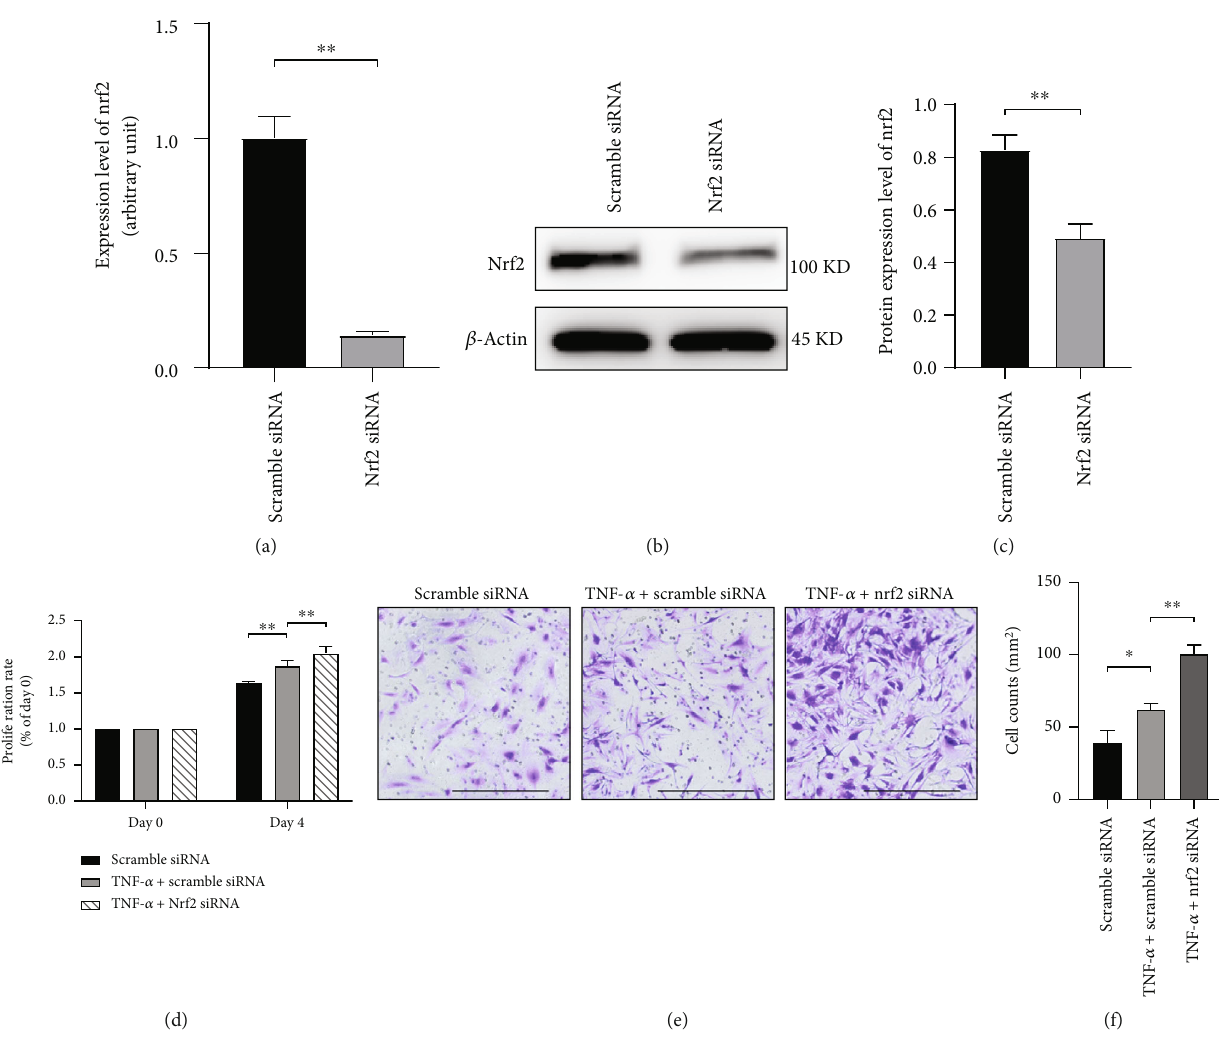
Figure 3: Knockdown of nrf2 promoted TNF- α -induced proliferation and invasion of RA-FLS. (a) Nrf2 mRNA expression was reduced by nrf2 siRNA transfection for 48 h, as revealed by real-time PCR. (b, c) The protein expression level of nrf2 was examined after nrf2 siRNA transfection for 72h by Western blotting. β -Actin was used as the housekeeping gene. (d) The proliferation rate of RA-FLS was analyzed by CCK-8 assay after transfection with scramble siRNA or nrf2 siRNA for 72h. Cells were examined before and after 4 days of culture in the presence or absence of TNF- α (25 ng/mL). The proliferation rate was expressed as the relative optical density (OD) value at 450nm between day 4 and day 0. (e, f) Invasion of RA-FLS was analyzed with transwell assay after transfection with scramble siRNA or nrf2 siRNA for 72 h. Cells were cultured in the transwell chamber coated with Matrigel in the presence or absence of TNF- α (25 ng/mL). The density of cells that migrated to the lower side of the membrane represented the cell invasion ability, as visualized by crystal violet staining. Pictures were taken at 200 magni fi cation. Scale bar represented 200 μ m. N = 3 . Data were shown as the mean ± SD ; ∗ p < 0 : 05 and ∗∗ p < 0 : 01